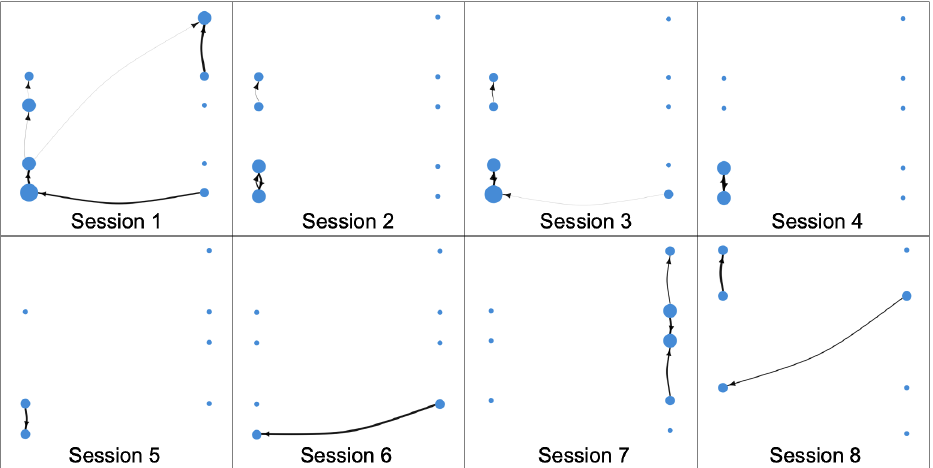
FIG. 13. Network diagrams for all coded sessions of section